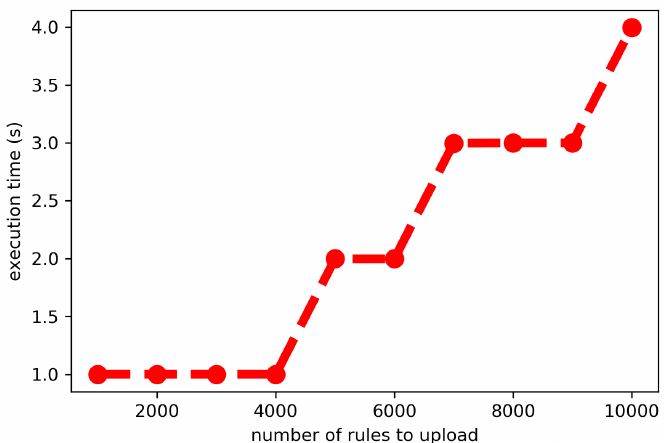
Figure 3. The speed of loading rules into the database for batches of 1000, 2000, ..., 10,000 rules.